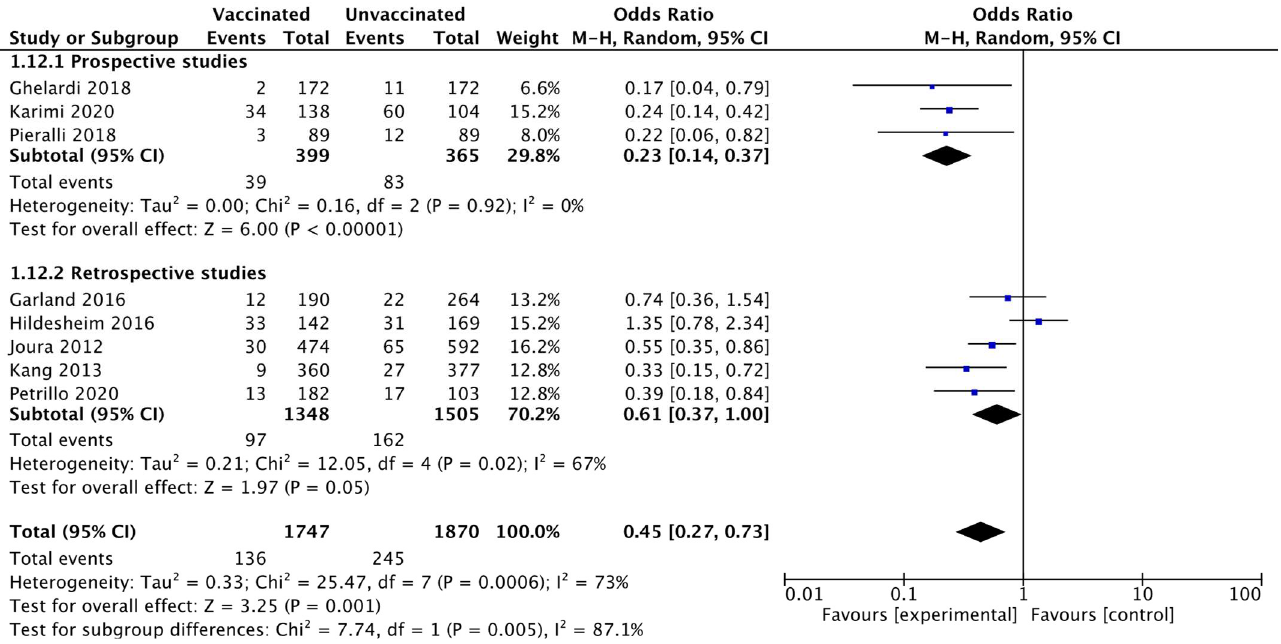
Figure 6. Forest plot of comparison: subgroup analysis related to the study design for CIN 1+ recur- rence.